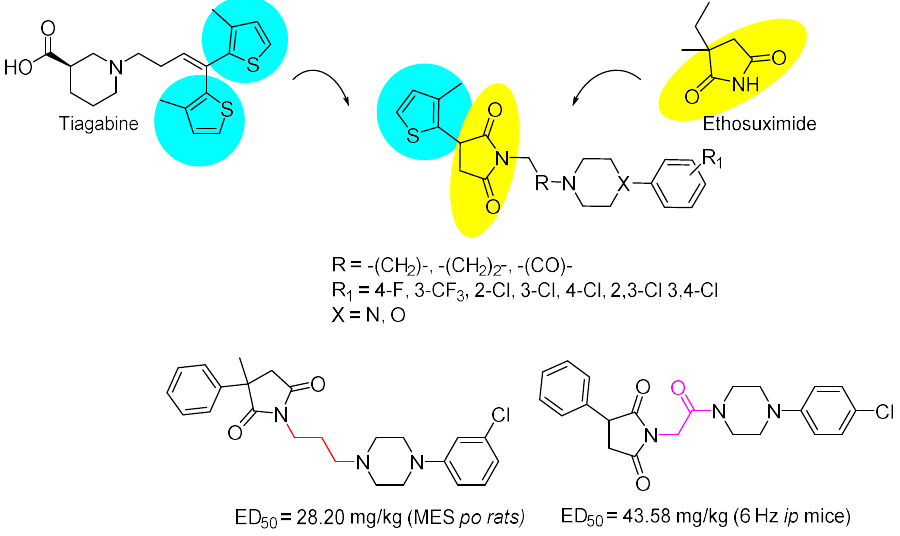
Figure 1. Proposed structural modifications and active compounds obtained in the previous studies [14,15].